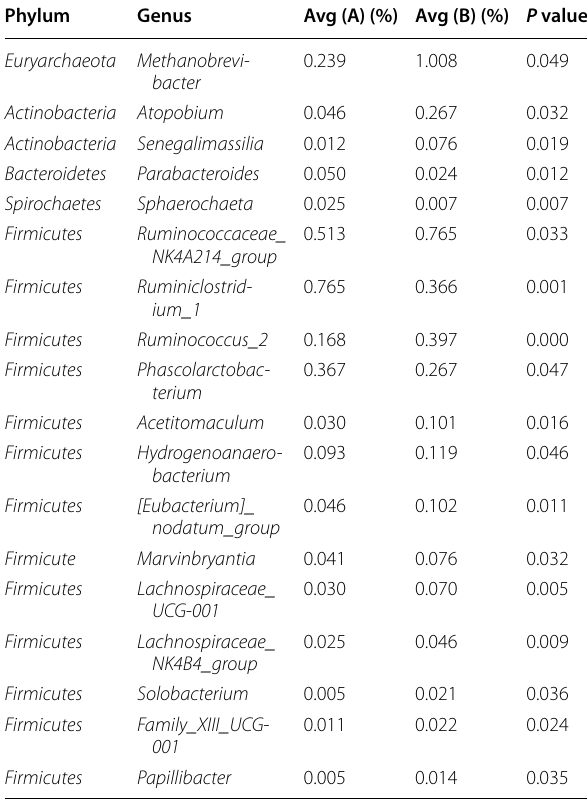
Table 4 Seasonal (winter and spring) comparisons for spe- cies abundance at the genus